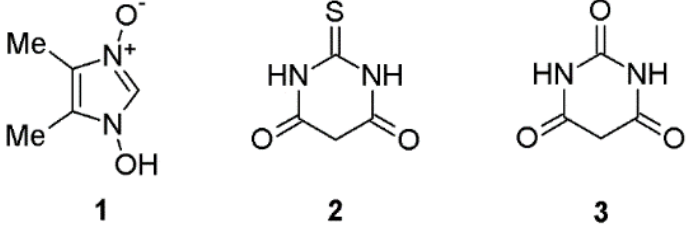
Figure 1. 1-Hydroxy-4,5-Dimethyl-Imidazole 3-Oxide (HIMO) ( 1 ), thiobarbituric acid (TBA) ( 2 ) and barbituric acid (BA) ( 3 ).